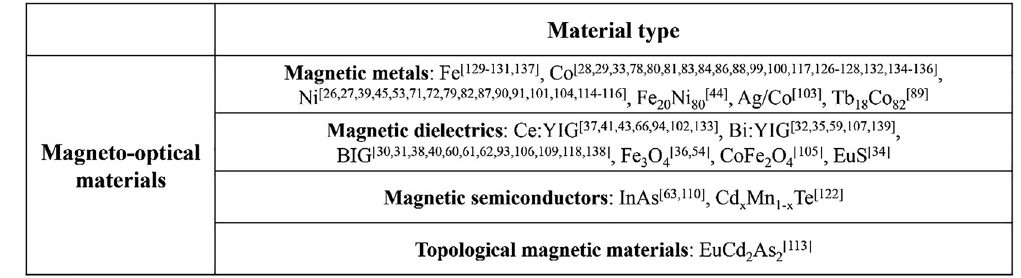
Figure 1: The MO materials reported in this